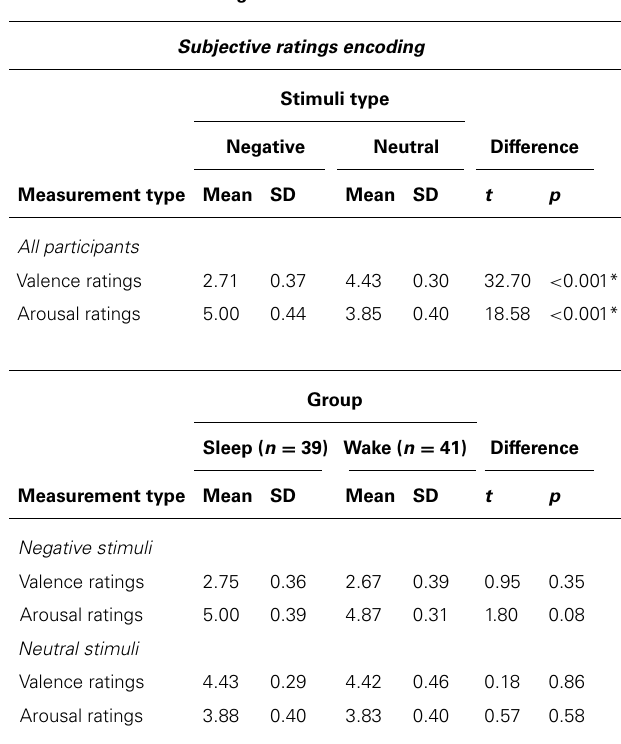
Table 1 |Average subjective and visceral reactivity to negative and neutral scenes at